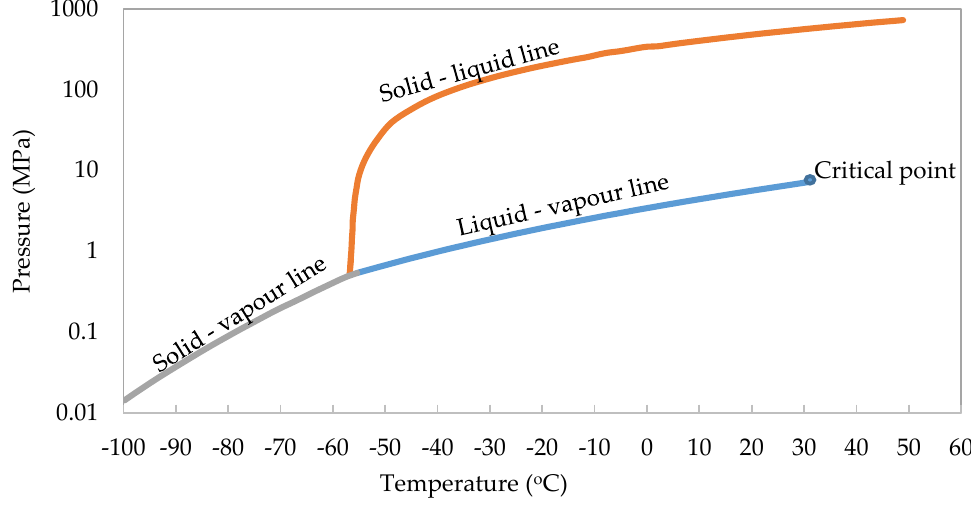
Figure 4. Phase diagram of pure CO 2 [8,21,37].